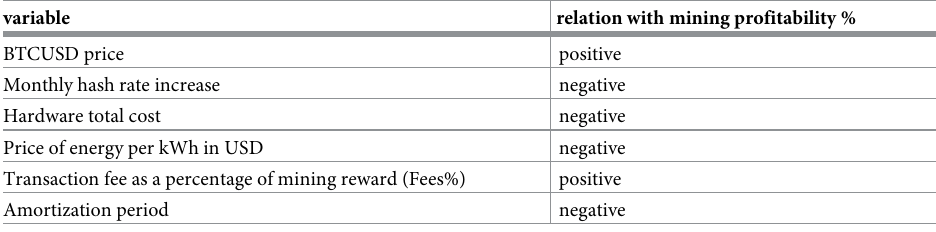
Table 4. Conclusions of sensitivity analysis.